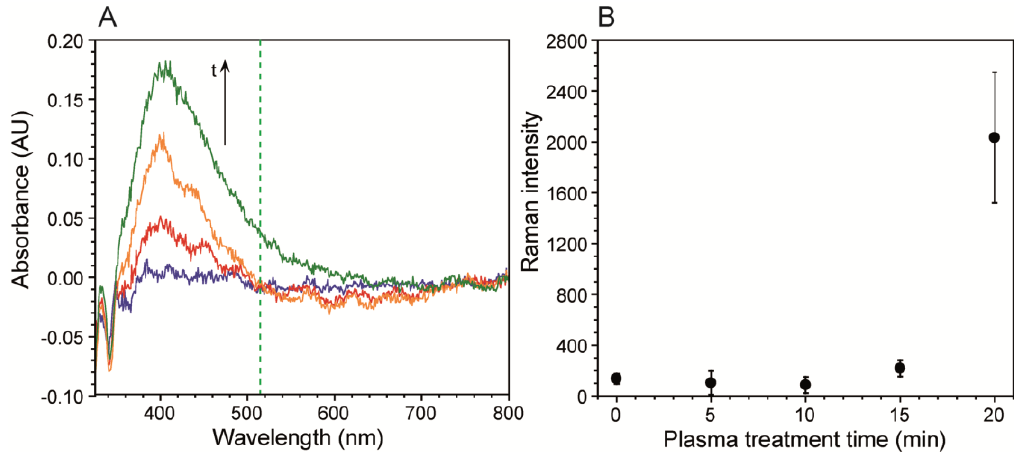
Figure 2. ( A ) UV-Vis spectra of the silver surface after 1 (blue), 5 (red), 10 (orange) and 19 (green) minutes of plasma treatment. Spectra were acquired in diffuse reflectance mode with an integration time of 0.6 s and 1nm data intervals. Each absorbance spectrum in (A) was generated using the spectrum of the silver surface after 0 min plasma treatment as the background spectrum. The green broken line at 514.5 nm in (A) represent the wavelength of the excitation laser source; ( B ) Raman intensity for the νC-COO band of sodium citrate at 952 cm −1 with increasing plasma treatment times using a 514.5 nm excitation laser. Air plasma treatments were done at power of 29.6 W at pressure of 600 mTorr. Error bars were generated for separate measurement at different locations on the same